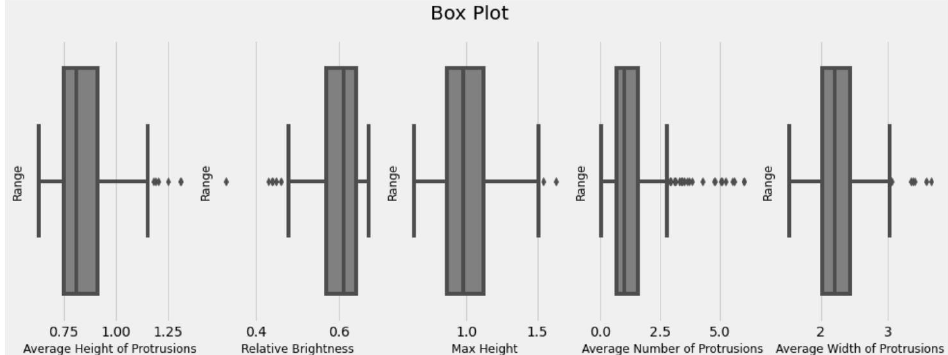
Figure 7. Box plot for important features.